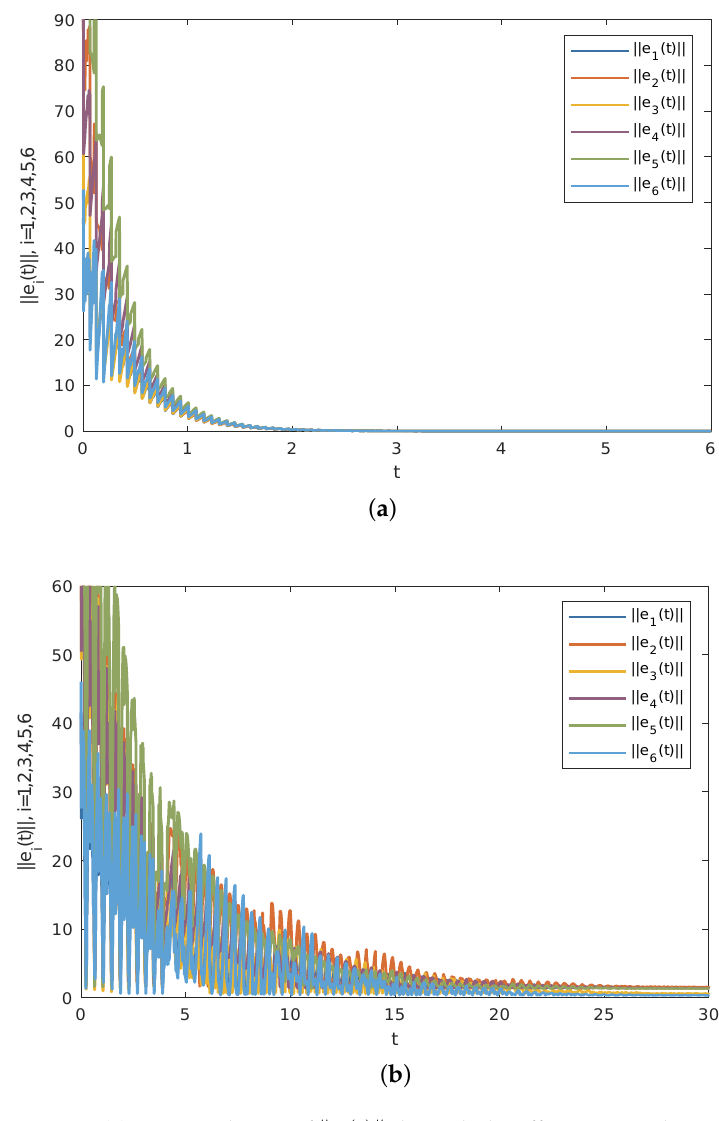
Figure 2. ( a ) Time evolution of (cid:107) e i ( t ) (cid:107) through the effective impulsive matrix M . One can see that (cid:107) e ( t ) (cid:107) approach zero over time, which shows complex networks (23) and (22) can achieve synchro- i nization in this case. ( b ) Time evolution of (cid:107) e i ( t ) (cid:107) through the impulsive gain matrix M ∗ = M + 0.1 I